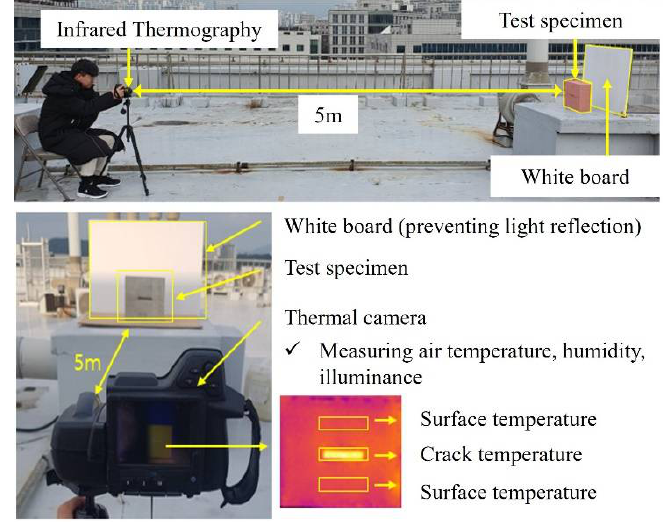
Figure 3. Test setup. Figure 3. Test Table 2. Specification of the thermal camera [27].